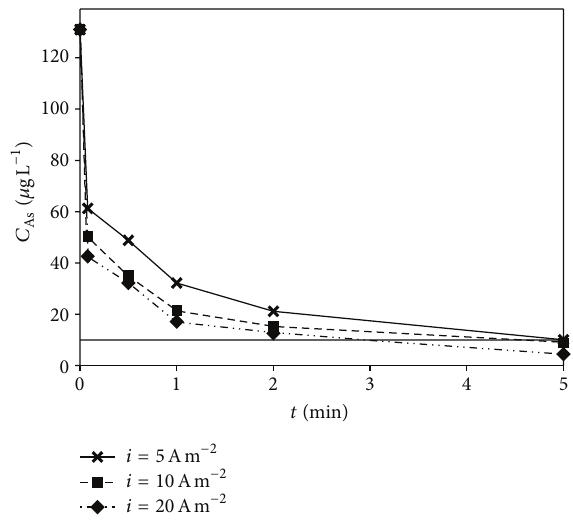
Figure 3: Kinetics of total As removal for treatments with a continuous flow of 1.00 Lmin −1 and current densities of 5, 10, and 20 Am −2